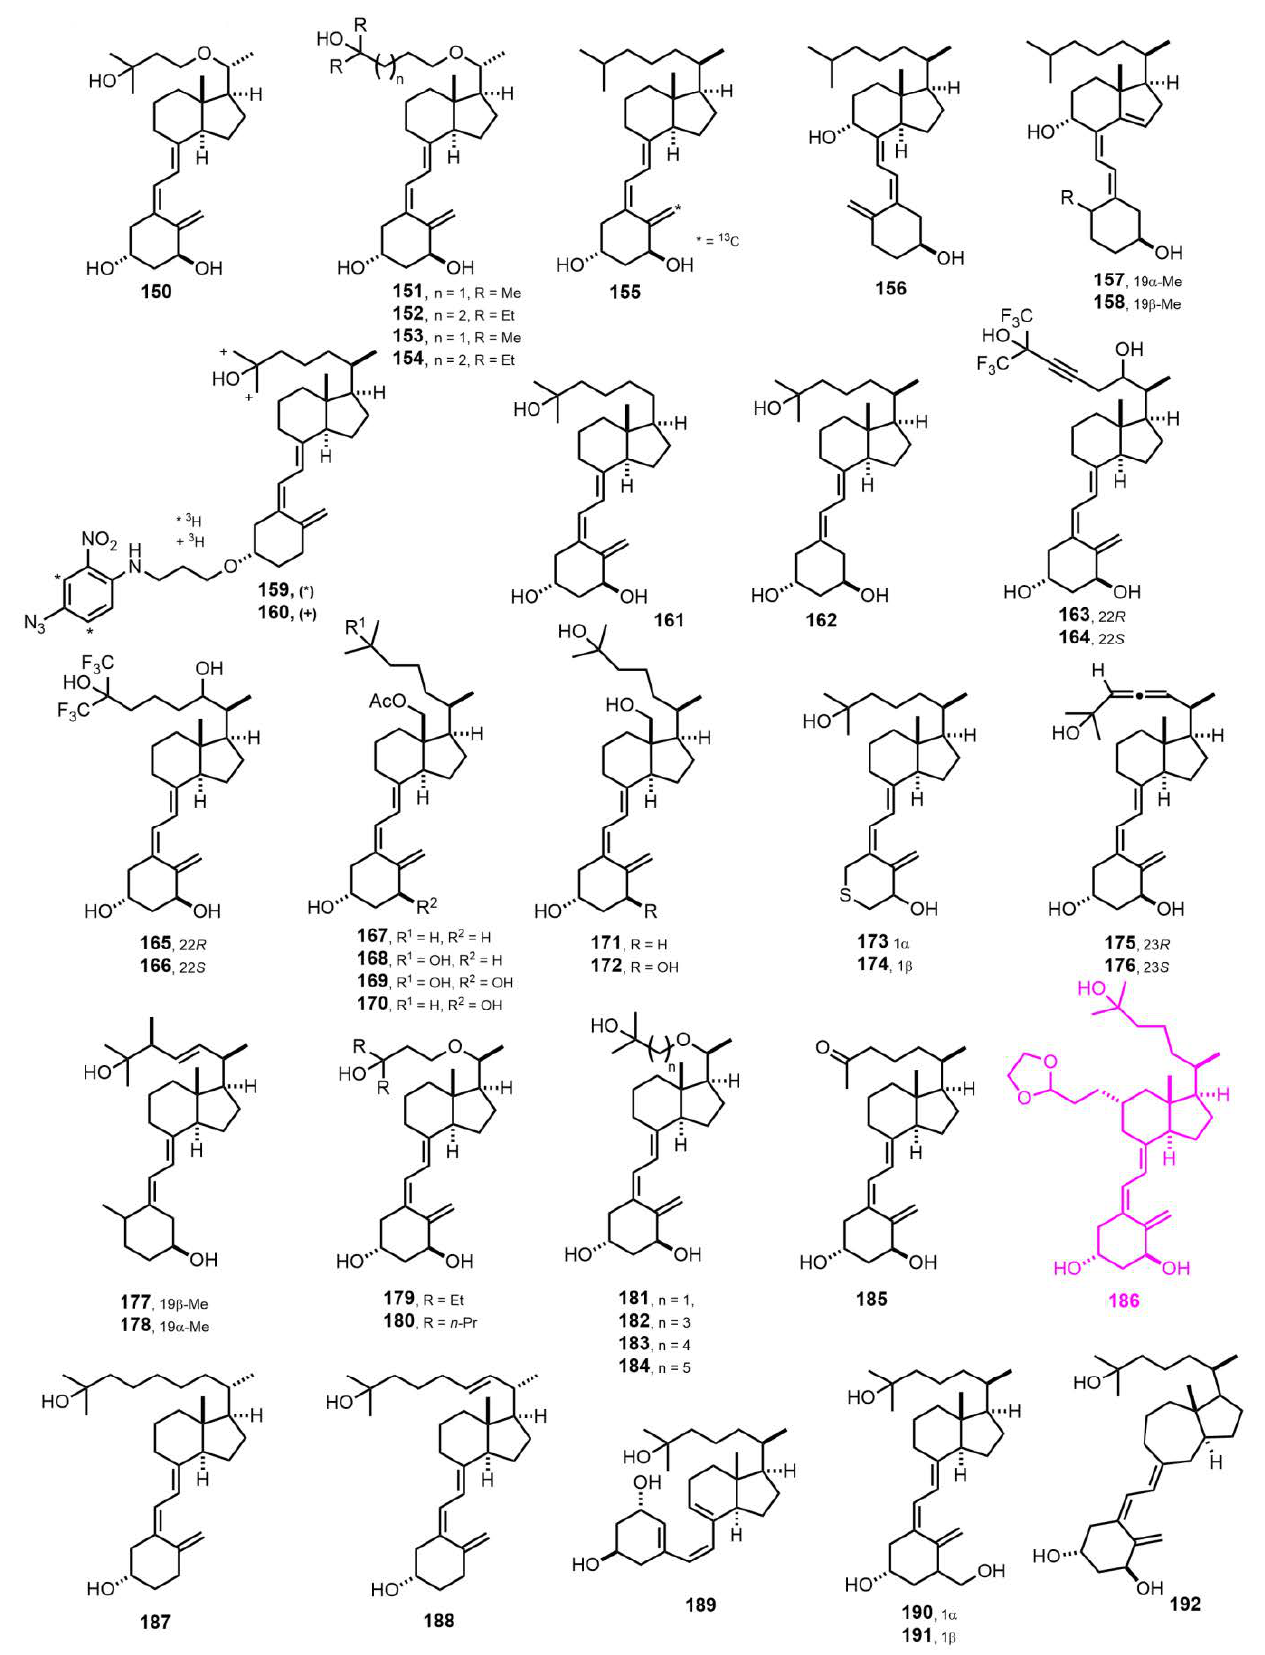
Figure 5. (1991–1992)